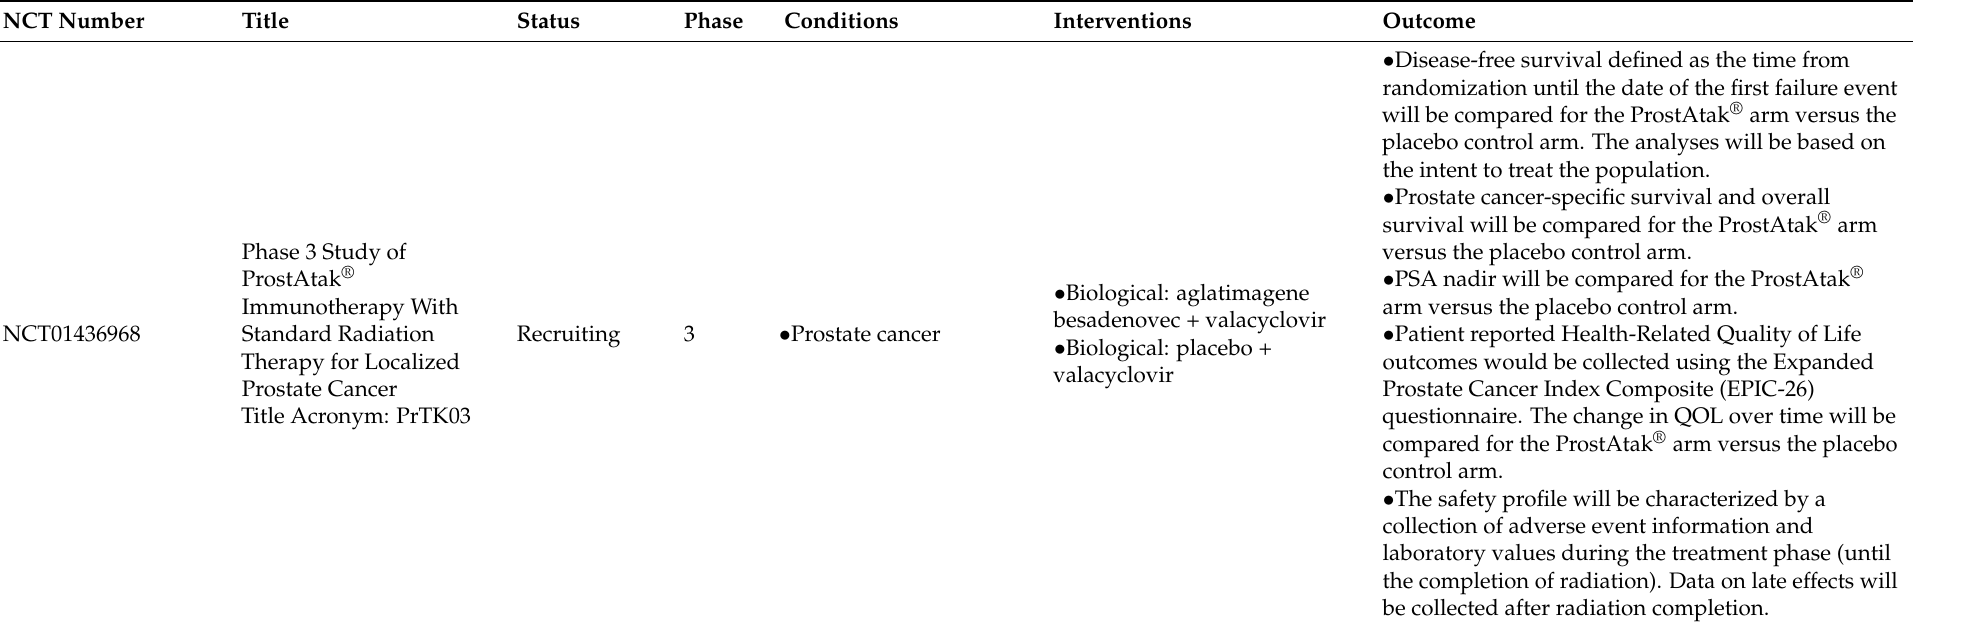
Table A2. Select ClinicalTrials investigating safety of Vaccines—19 September 2021